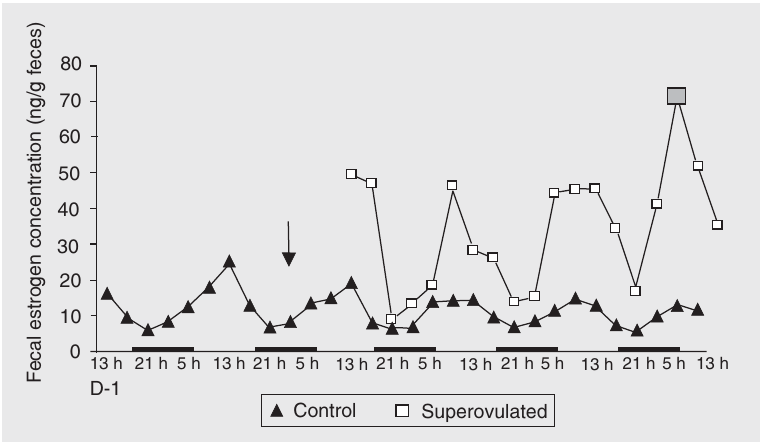
Figure 1. Changes in mean fecal estrogen concentration during the 4-day estrous cycle of two groups of adult female hamsters. Samples were collected at 4-h intervals throughout the cycle. The day after ovulation was designated as day 1 (D-1) of the cycle. The arrow indicates the estimated time of ovulation. The grey square indicates the time of hCG injection into superovulated females. Dark bars on the x-axis indicate “lights out”. Each value represents the mean of 7 observations (normally distributed).